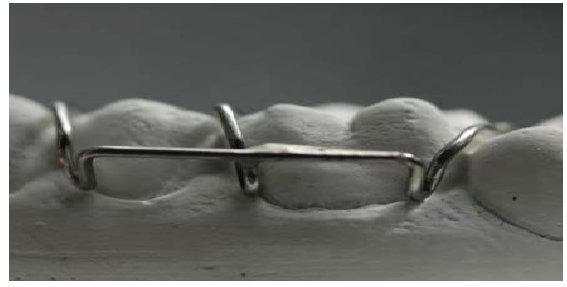
Fig. Adam’s clasp with additional arrowhead